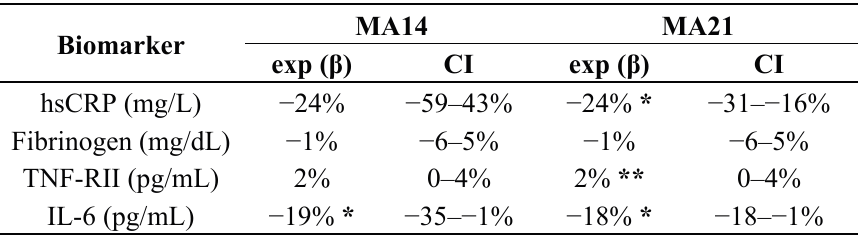
Table 6. Mean change and 95% confidence intervals (CI) in blood biomarker concentrations per 10 4 particles/cm 3 increase in PNC moving average (MA) (14- or 21-day MA) adjusted for baseline blood biomarker